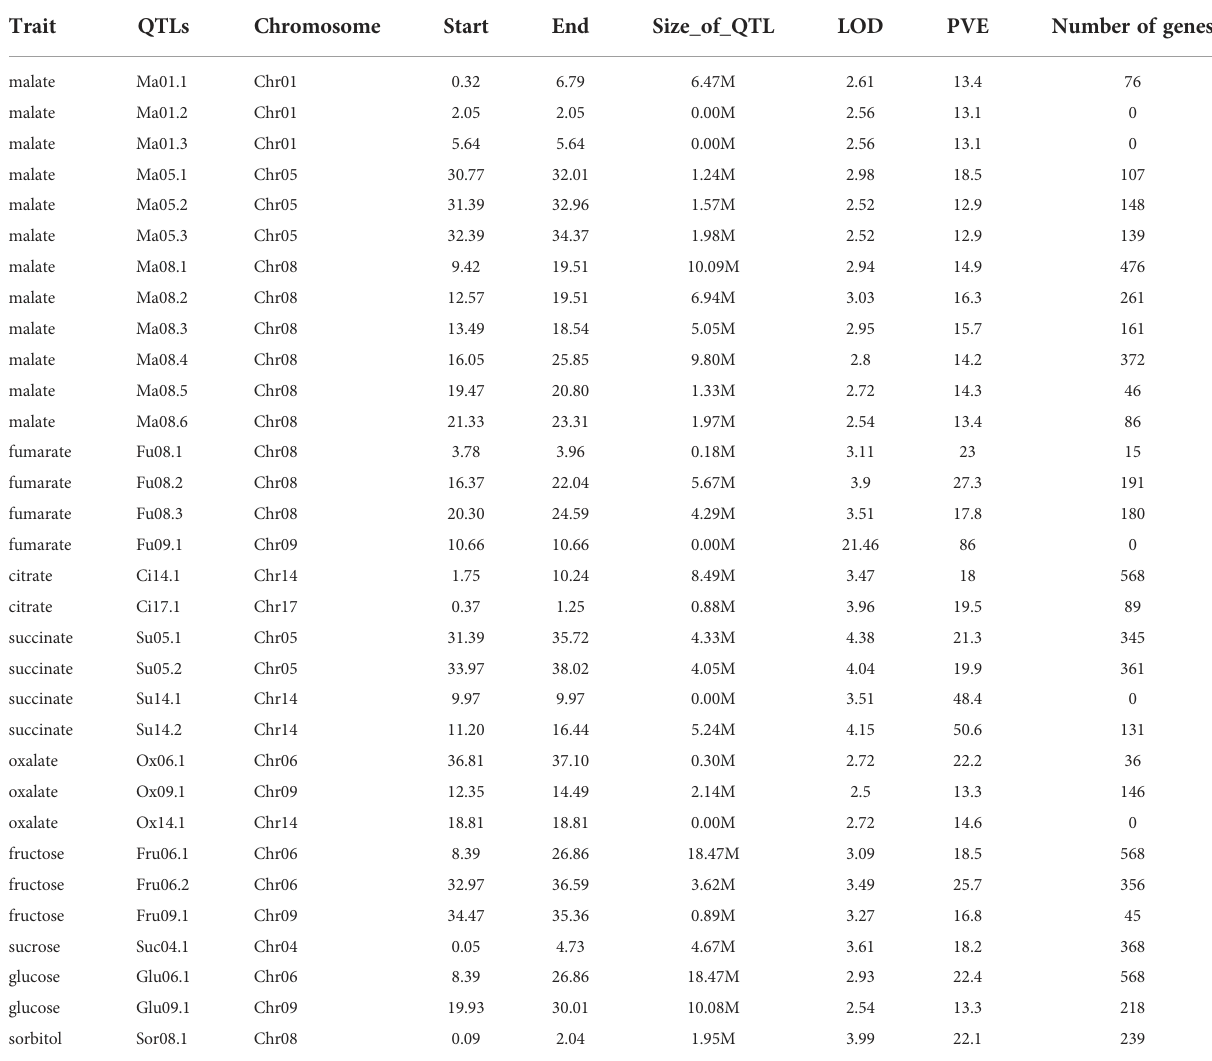
TABLE 1 Summary statistics for the classi fi cation of signi fi cant QTL for sugars and acids. Trait